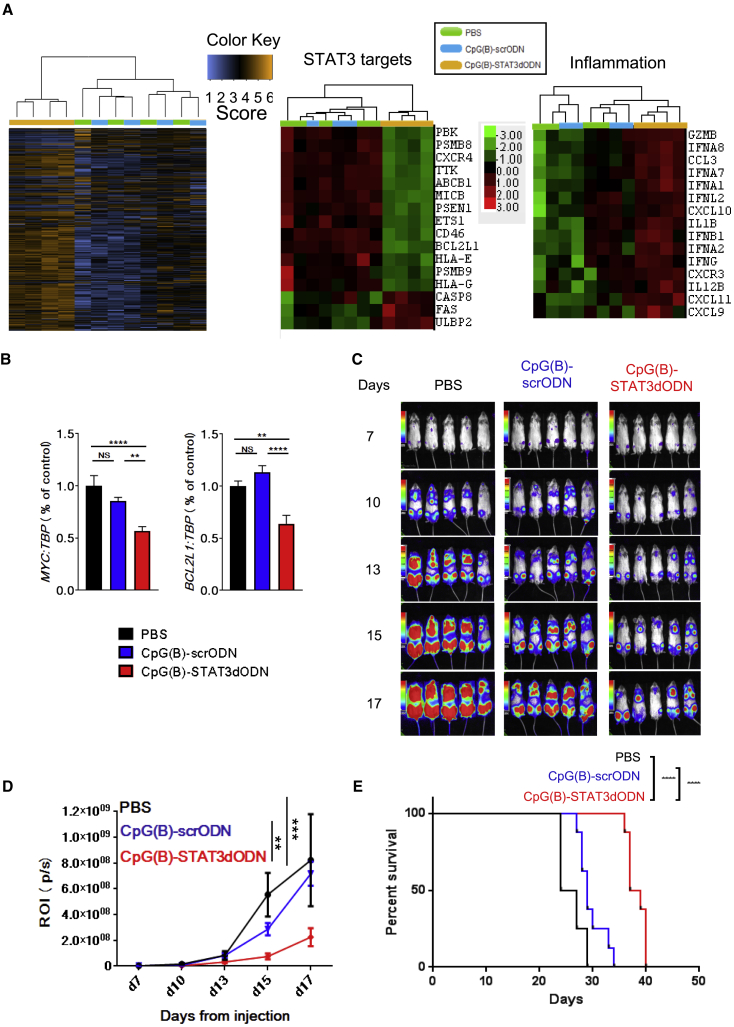
CpG(B)-STAT3dODN Inhibits Growth of Disseminated Human BCL(A and B) Local CpG(B)-STAT3dODN treatment reduces STAT3 signaling in OCI-Ly3 lymphoma xenotransplants. 1 × 107 OCI-Ly3 cells were engrafted s.c. into NSG mice. Mice with established lymphoma were injected IT 3 times every day using 1 mg/kg CpG(B)-STAT3dODN, CpG(B)-scrODN, or PBS (n = 4). Total RNA isolated from harvested tumors was analyzed using NanoString analysis and the human-specific PanCancer Immune Profiling panel (A) and real-time qPCR (B). Data indicate means ± SEM. (C–E) Systemic administration of CpG-STAT3dODN inhibits growth of the disseminated OCI-Ly3LUC lymphoma. 5 × 106 OCI-Ly3LUC cells were engrafted intravenously into NSG mice. Starting from day 7 after engraftment, mice were treated once daily for 10 days using injections (intravenous) of 10 mg/kg CpG(B)-STAT3dODN, CpG(B)-scrODN, or PBS alone. (C) Tumor progression was monitored using bioluminescent imaging (BLI); shown are representative images. (D) Tumor growth kinetics are indicated as assessed using quantification of the BLI signal during the experiment. ROI, regions of interest; p/s, photons per second. Data indicate means ± SEM (n = 5 per each group). (E) Systemic administration of CpG(B)-STAT3dODN extends the survival of OCI-Ly3-bearing mice. Shown are Kaplan-Meier survival curves derived from one of two independent experiments (n = 8). **p < 0.01; ***p < 0.001, ****p ≤ 0.0001; NS, not significant.